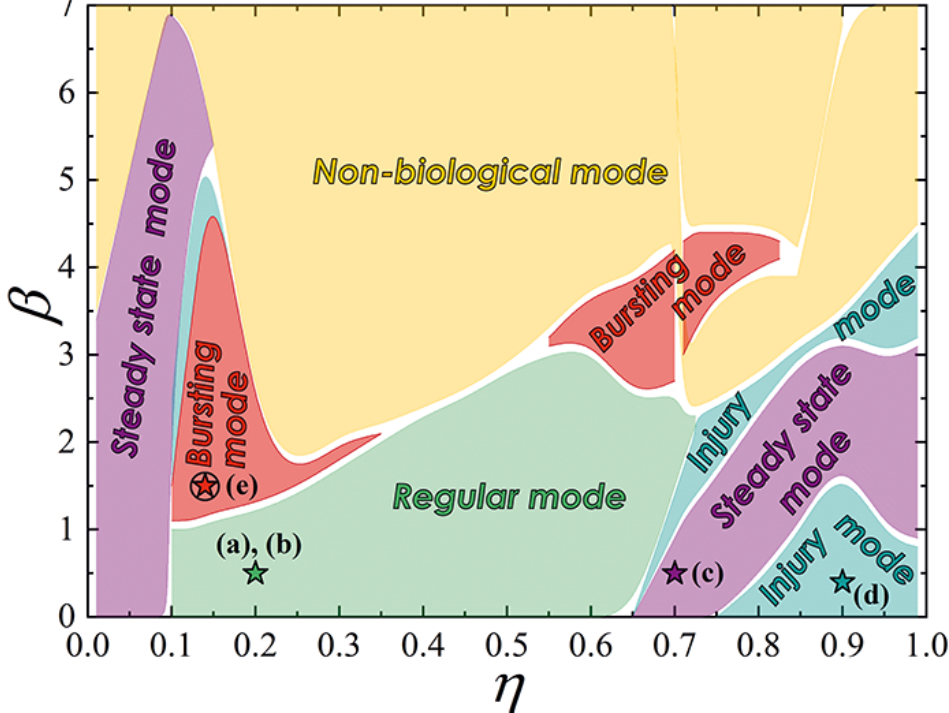
Figure 5. Map of the proposed bio-inspired neuron operating modes on the plane of parameters ( β , η ). White boundaries represent the areas where transient processes complicating identification of a partic- ular mode take place. Stars mark parameters taken for simulations presented in Figure 4. The regular, steady state, and injury modes can be obtained in the overdamped circuits ( β −→ 0) such as the studied experimental samples. Implementation of the bursting mode requires underdamped